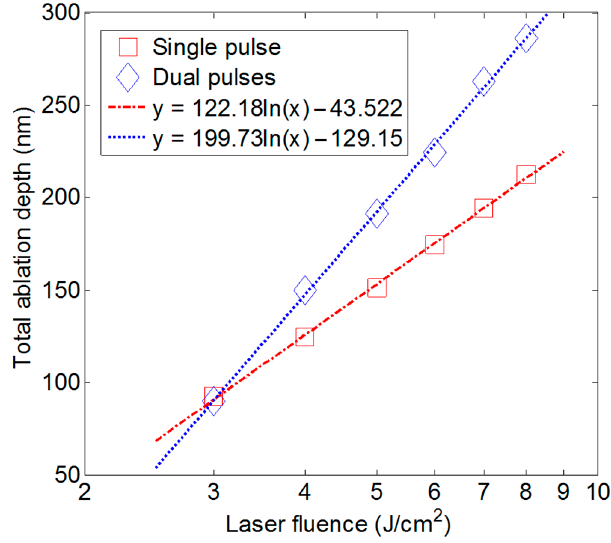
Figure 4. Variation in the ablation depth between single and dual pulses with laser fluence.